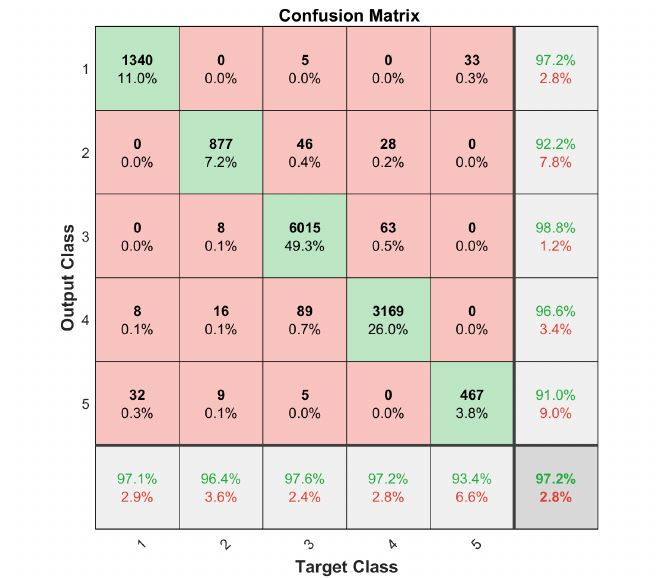
Figure 8. Classification accuracy of balanced training of 1627